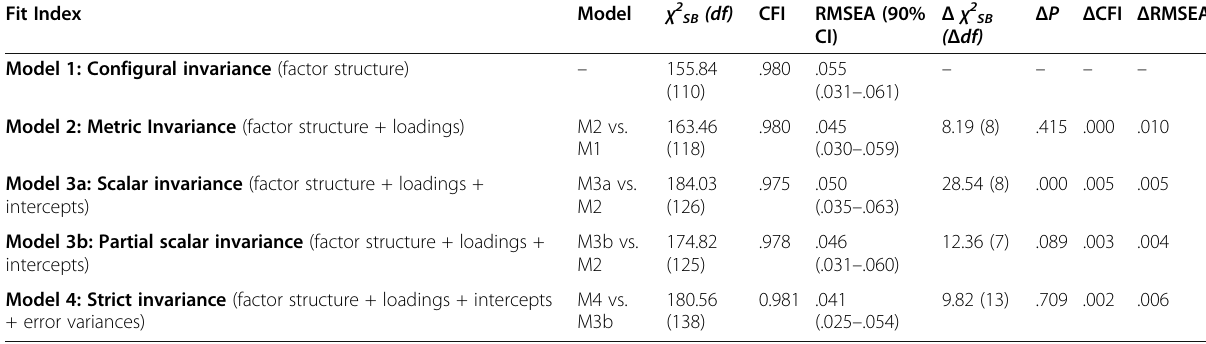
Table 4 Summary of testing measurement invariance between minoritized women and majoritized women